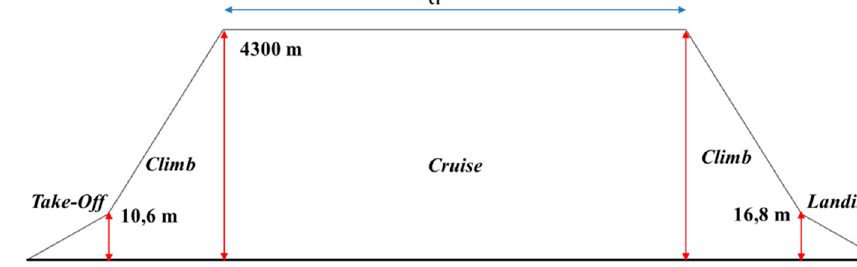
Figure 5. Considered mission profile.